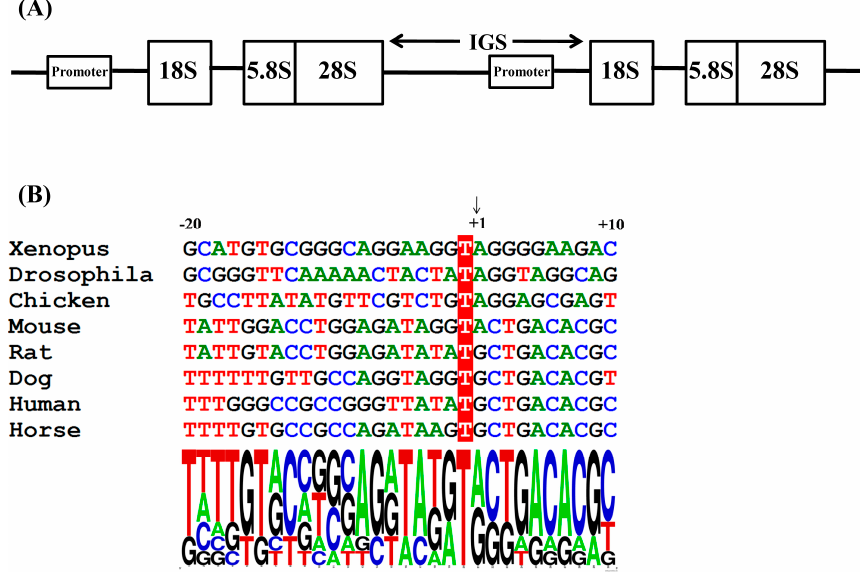
Figure 1. Molecular mapping of the horse RNA PolI promoter. ( A ) Map of horse ribosomal DNA: 5.8S, 18S, and 28S rRNAs are in clusters of head-to-tail repeats. The intergenic spacer (IGS) region is located between the 28S and 18S rRNA coding sequences and contains the horse RNA PolI promoter sequence; and ( B ) alignment of the sequences around the RNA PolI transcription initiation site of horse and other species. The transcription initiation site is indicated by an arrow and labeled as +1. The conserved − 1 position (T) is shown with a red background. The base frequency around the RNA PolI transcription initiation site is identified using the WebLOGO tool [25].